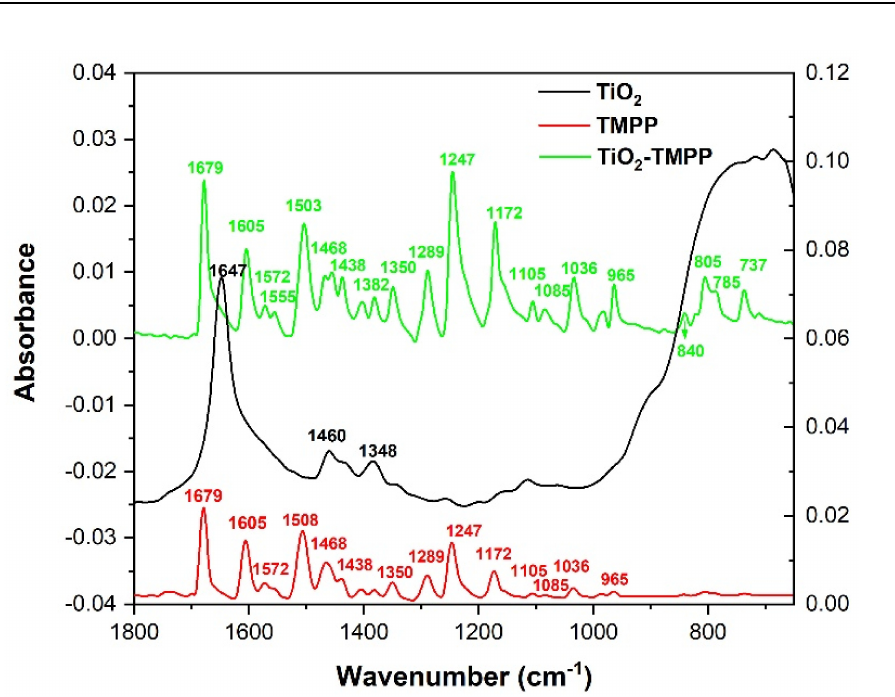
Figure 5. FTIR–ATR spectra of TiO 2 NPs, TMPP, and TiO 2 NPs loaded with TMPP. Left axis corre- sponds to TiO 2 -TMPP spectrum, while right axis corresponds to TiO 2 and TMPP spectra. The TiO 2 spectrum is vertically